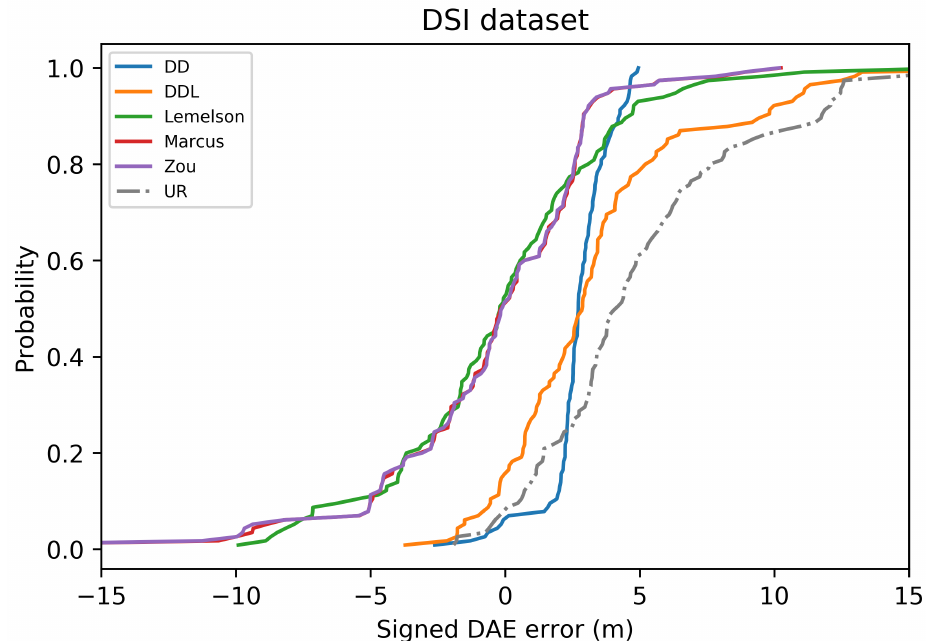
Figure 17. The Cumulative Distribution Function (CDF) of the signed DAE error (in meters) for all studied methods and one baseline, in the validation set of the DSI dataset. Negative values correspond to DAE overestimating the error (“ground-truth position inside the DAE circle”), while positive values correspond to DAE underestimating the error (“ground-truth position outside the DAE circle”).